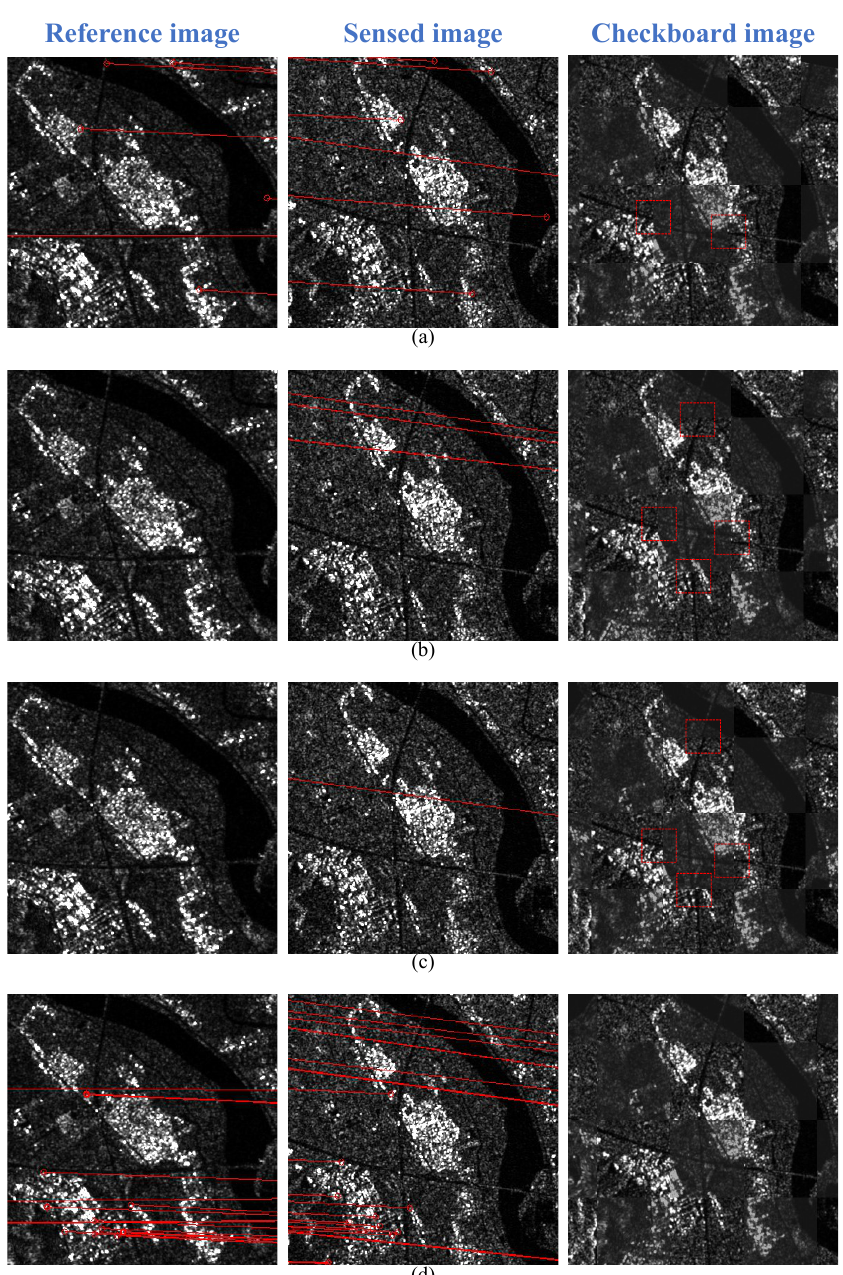
Figure 19. Enlarged maps of the registration results for pair 5 with different methods. ( a ) SAR-SIFT. ( b ) SOSNet. ( c ) Sim-CSPNet. ( d )